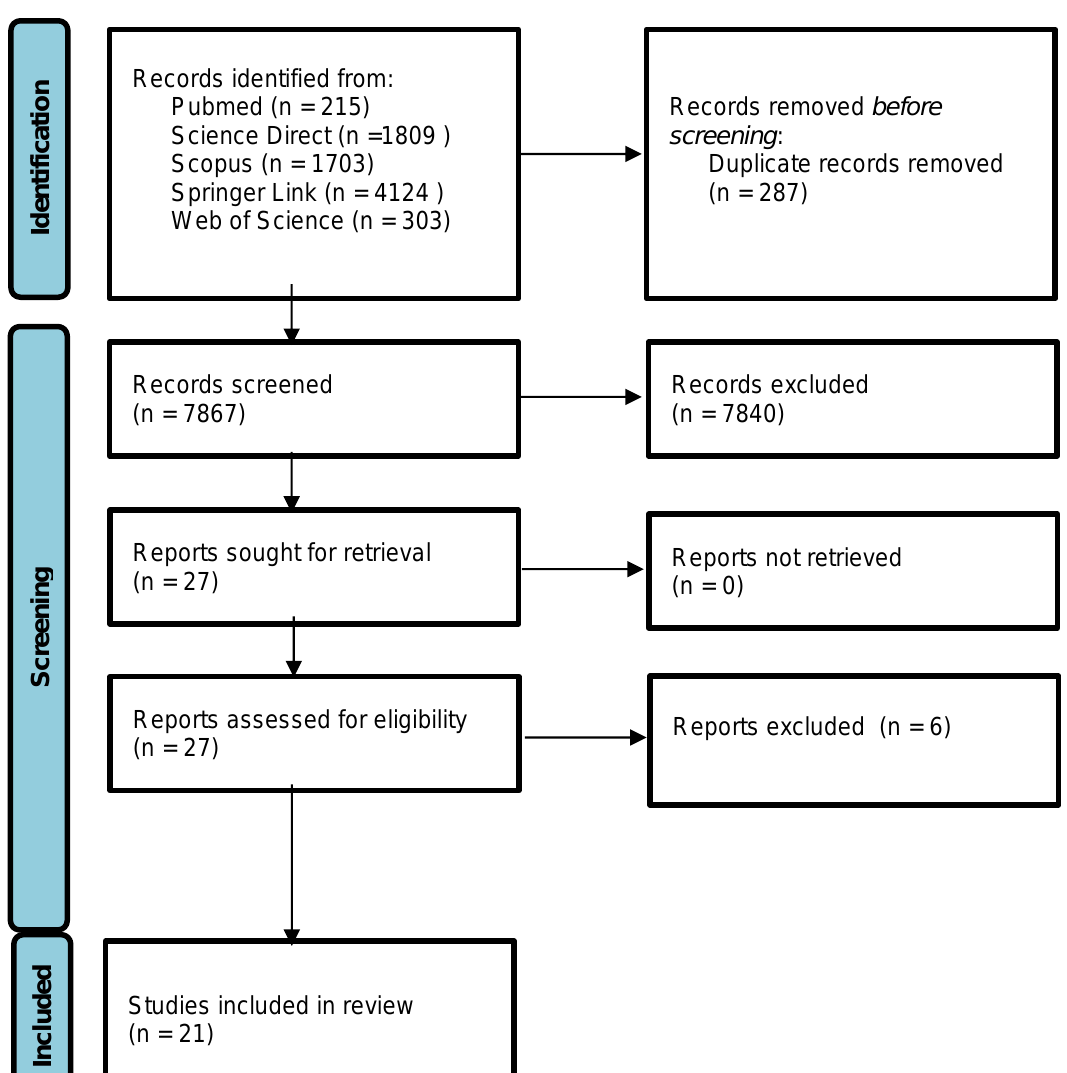
Fig. 1 PRISMA flow diagram for study selection. Figure 1. PRISMA flow diagram for study selection